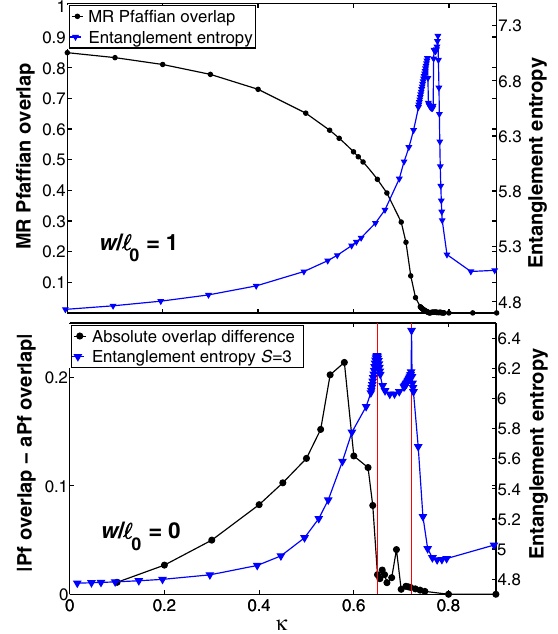
FIG. 13. Top panel: Entanglement entropy and wave-function overlap with the MR state for width w= l 0 ¼ 1 . Bottom panel: Entanglement entropy and the absolute difference of the MR Pfaffian and aPf overlaps for width w= l 0 ¼ 0 . In both cases, the spherical geometry is used with N Φ ¼ 29 and S ¼ 3 . The vertical red lines in the bottom panel are just a guide to the eye to indicate the peaks in the entanglement entropy.